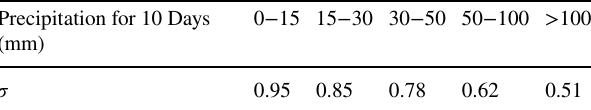
Table 4 Rainfall effective utilization coefficients of soybean for 10 days in the Huaibei Plain study area in Anhui Province, China Precipitation for 10 Days (mm)